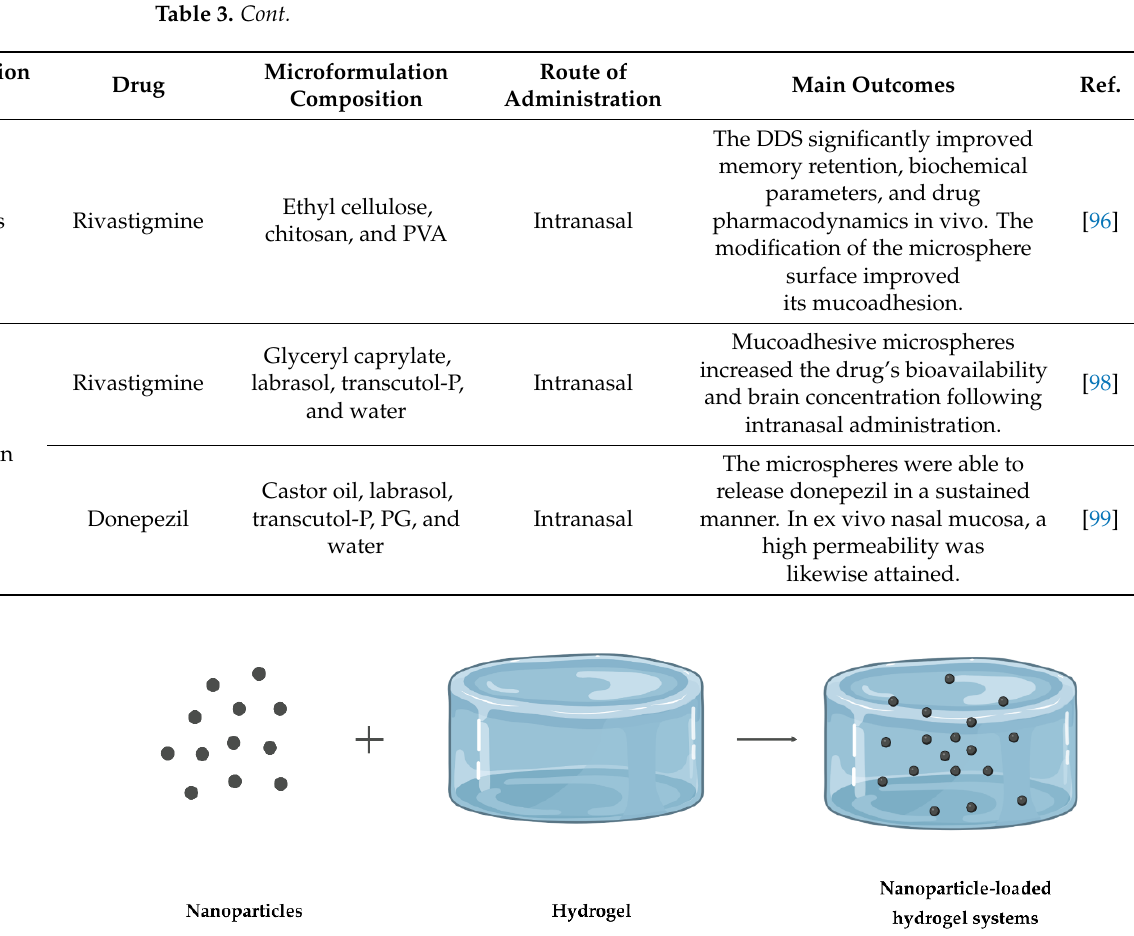
Figure 8. Schematic representation of the combination of loaded NPs and a hydrogel as DDS.